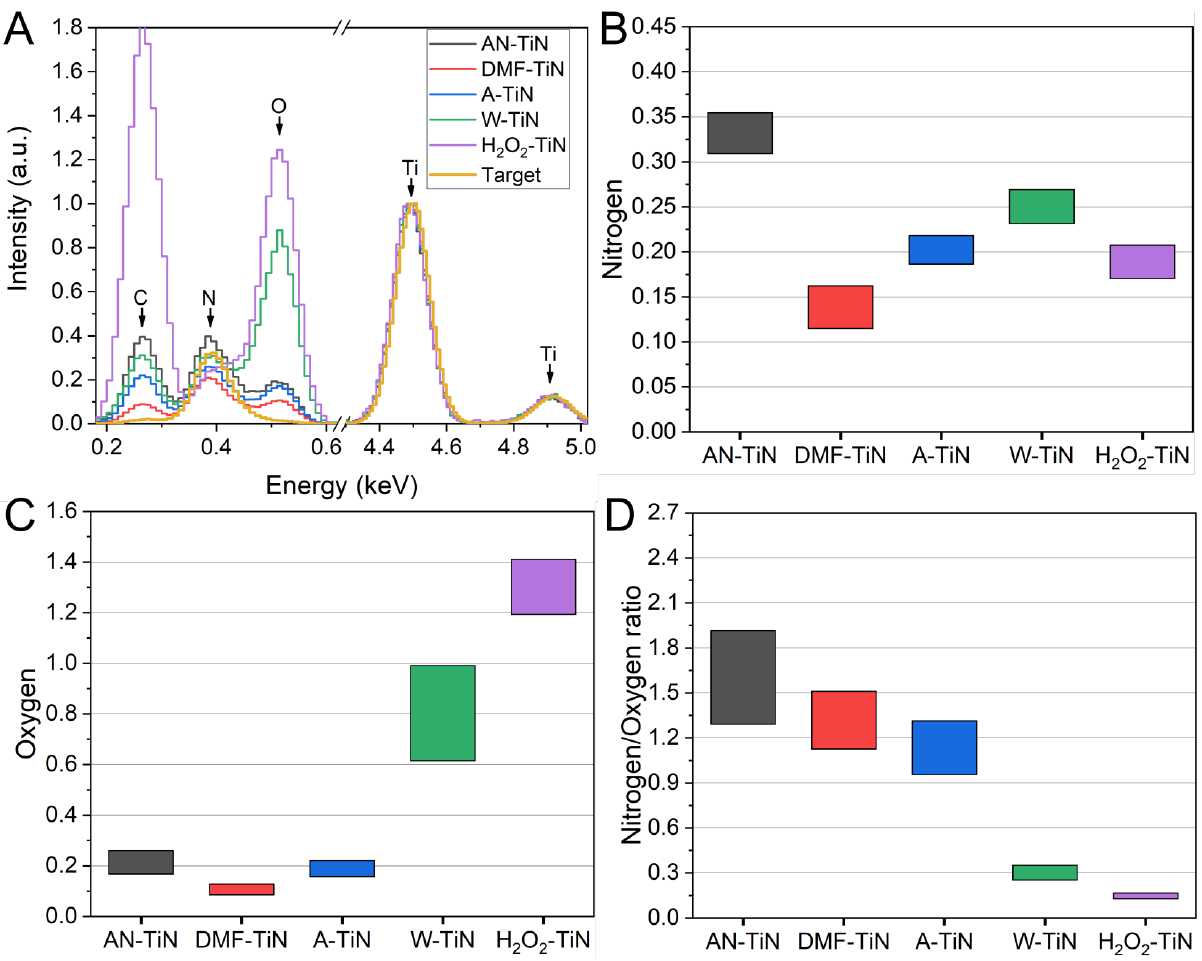
Figure 2. EDX characterization of synthesized TiN-based NPs. ( A ) Averaged background corrected EDX spectra (black line — AN-TiN NPs, red line — DMF-TiN NPs, blue line — A-TiN NPs, green line — W-TiN NPs, purple line — H 2 O 2 -TiN NPs, brown line — TiN ablation target). All spectra are normalized to titanium and averaged over all data points, measured on each sample. ( B ) Nitrogen and ( C ) oxygen content of synthesized NPs normalized to titanium. Values are calculated as the intensity of nitrogen peak at 0.39 keV or oxygen peak at 0.52 keV, divided by intensity of the Ti peak at 4.5 keV, respectively. ( D ) Ratio of nitrogen content to oxygen content in the NPs. Data in ( B – D ) are represented as mean ± standard deviation. At least seven different data points were measured on each sample.